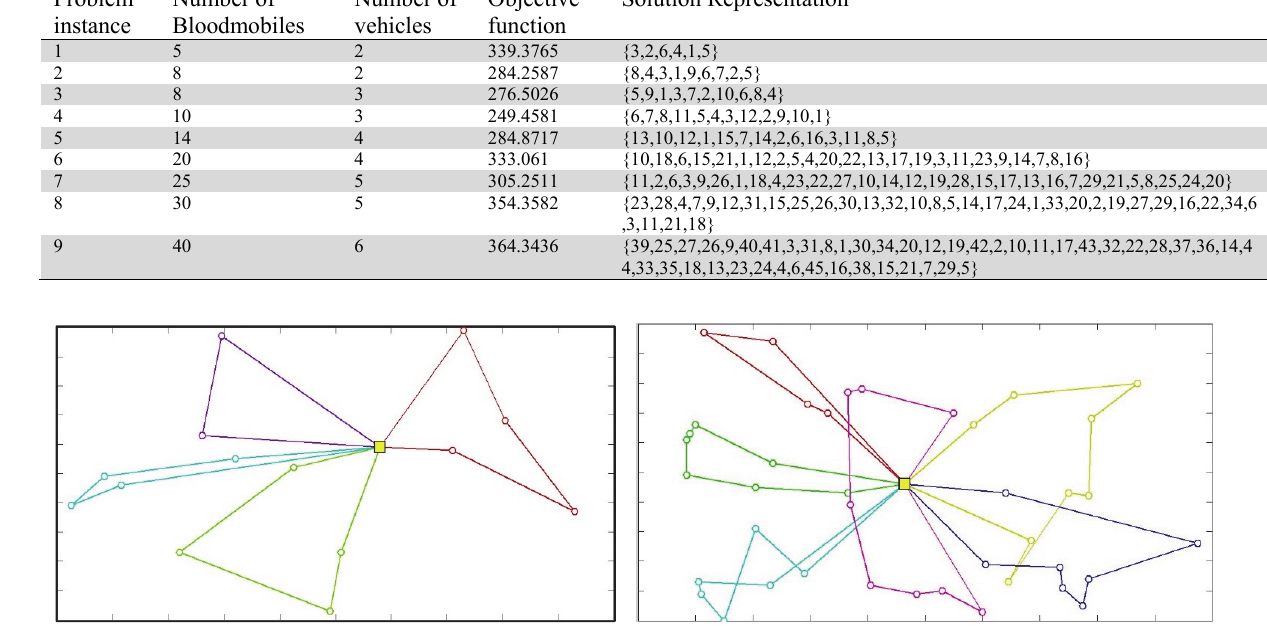
Fig. 7. Solution representation for problem instance 5 Fig. 8. Solution representation for problem instance